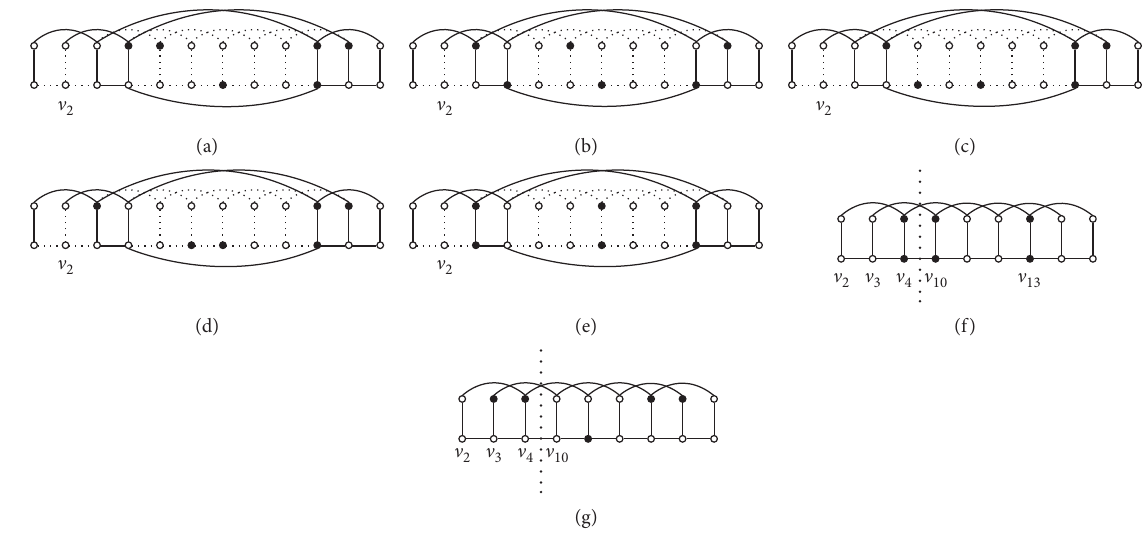
Figure 6: The four possible cases of S in Subcase